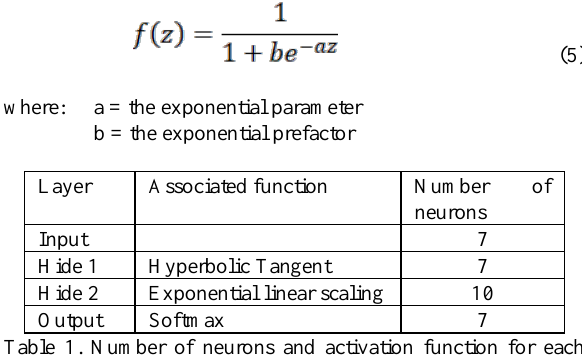
Table 1. Number of neurons and activation function for each